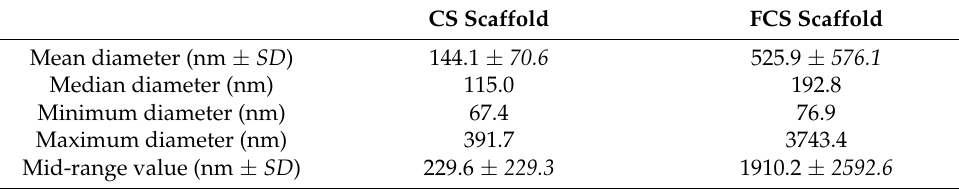
Table 2. Key fiber parameters of electrospun